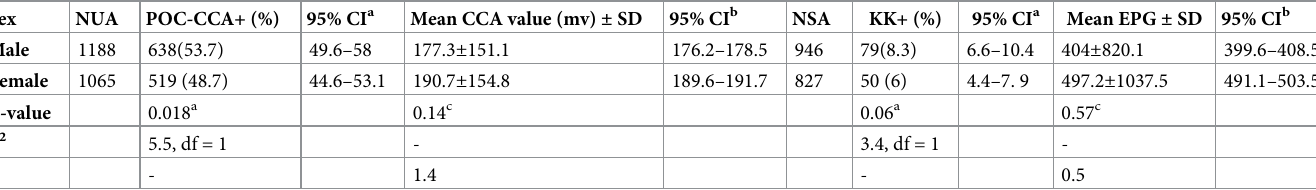
Table 3. Prevalence and infection intensity of S . mansoni infections according to sex.